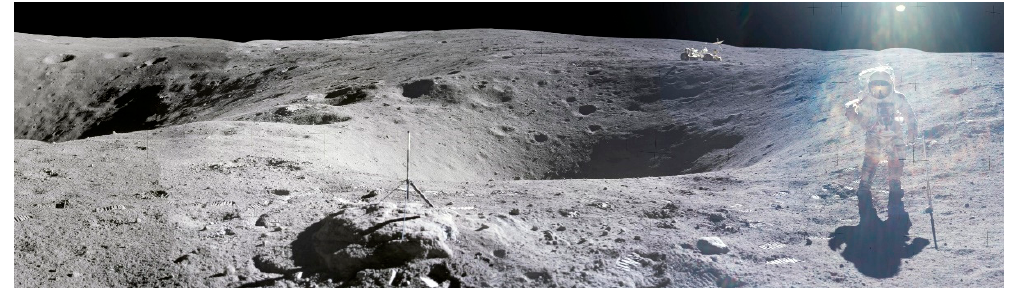
Figure 10. The landscape at the Apollo 16 landing site, near the Nectaris basin, but also amidst the topographic features radial to Imbrium basin. As suggested here, craters may have excavated Imbrium blanket material and/or underlying Nectaris materials. (Glare from the sun appears at right. Photo mosaic from Lunar and Planetary Institute web site).